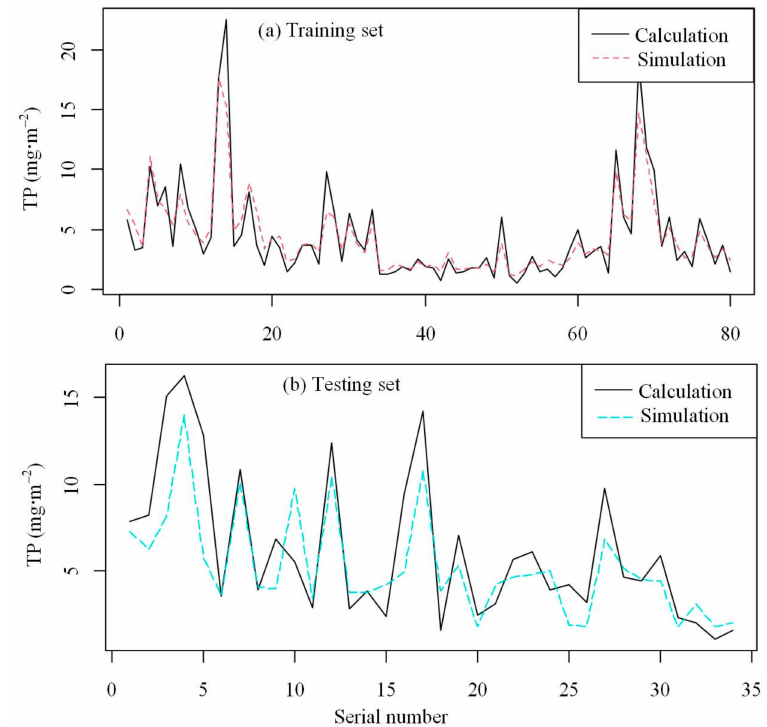
Figure 9. Calculated and simulated runoff TP loads of paddy fields based on RF.